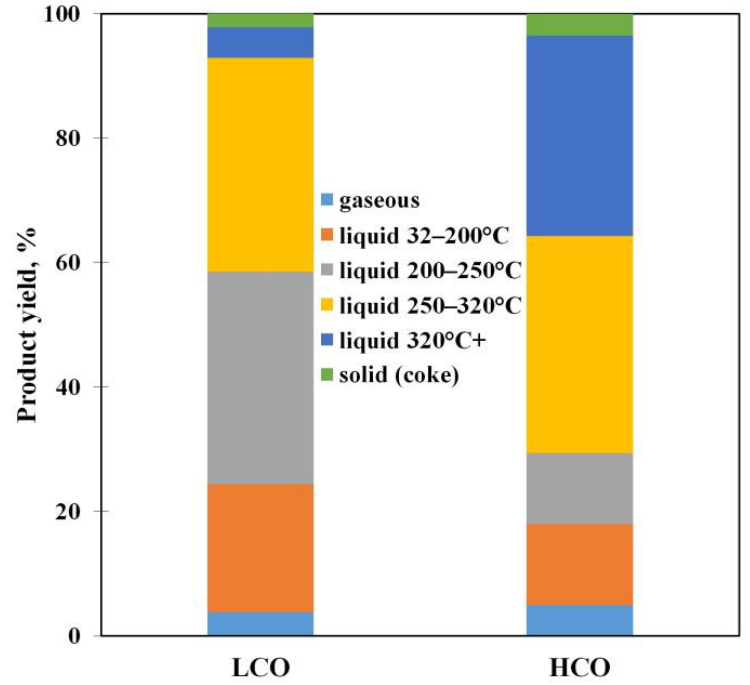
Figure 1. The product distribution of the LCO and HCO conversion at 550 ◦ C and WHSV 85 h − 1 . Table 4. The component distribution of gaseous and liquid products obtained via the conversion of pure LCO and HCO at 550 ◦ C and WHSV 85 h − 1 .